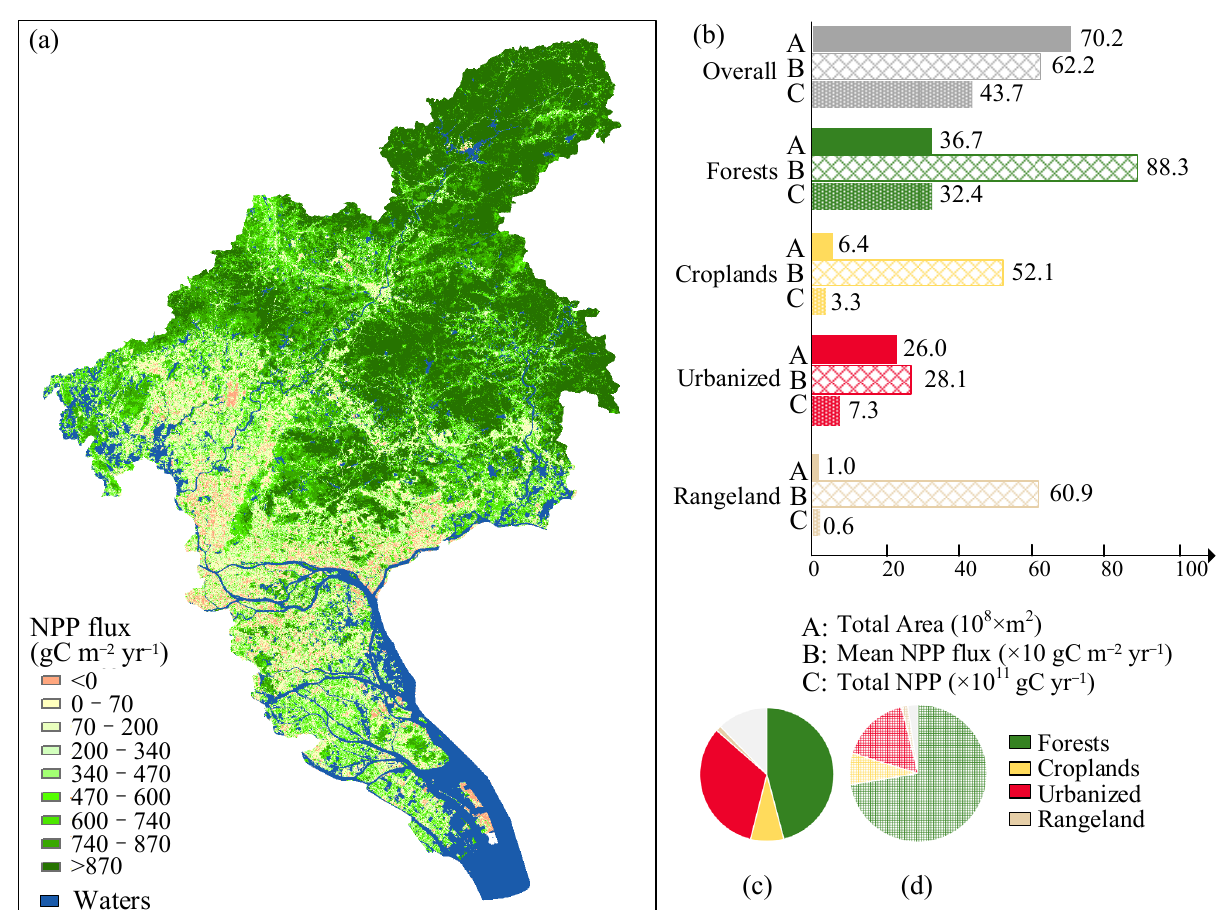
Figure 3. Distribution of NPP and statistics among different land cover classes. ( a ) NPP flux. ( b ) Land cover area, NPP flux, and total NPP among land cover classes. ( c ) Land area statistics of the land cover classes. ( d ) Contribution of carbon uptake from vegetation in the different land cover types.